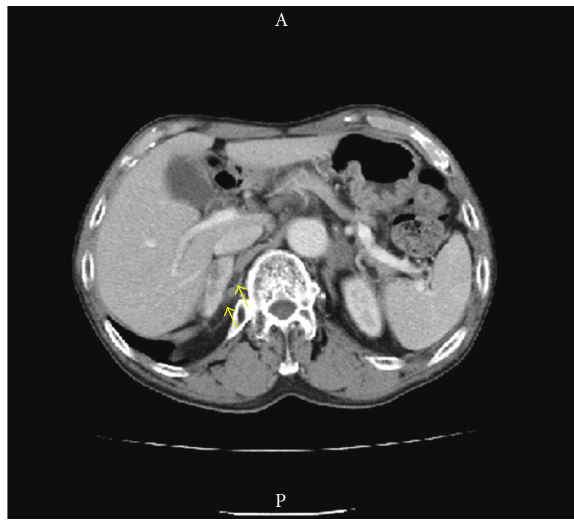
Figure 2: Computed tomography at 6 months after the left adrenalectomy shows right adrenal tumor (5.0 × 1.8